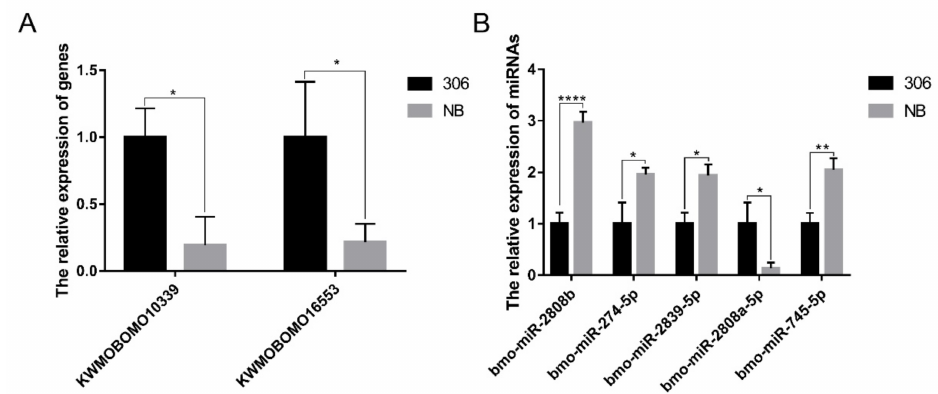
Figure 8. The relative expression profile of the I gene and the regulated miRNA between the yel- low and white cocoon silkworm. ( A ): The relative expression level of I gene (KWMTBOMO10339 and KWMTBOMO16553), NB group compared with 306 group; ( B ): The relative expression level of the miRNA (bmo-miR-2839-5P, bmo-miR-2808b, bmo-miR-2808a-5P, bmo-miR-745-5P, and bmo-miR-274-5P), NB group compared with 306 group. All the data was repeated thrice. *, p < 0.05; **, p < 0.01; ****, p <